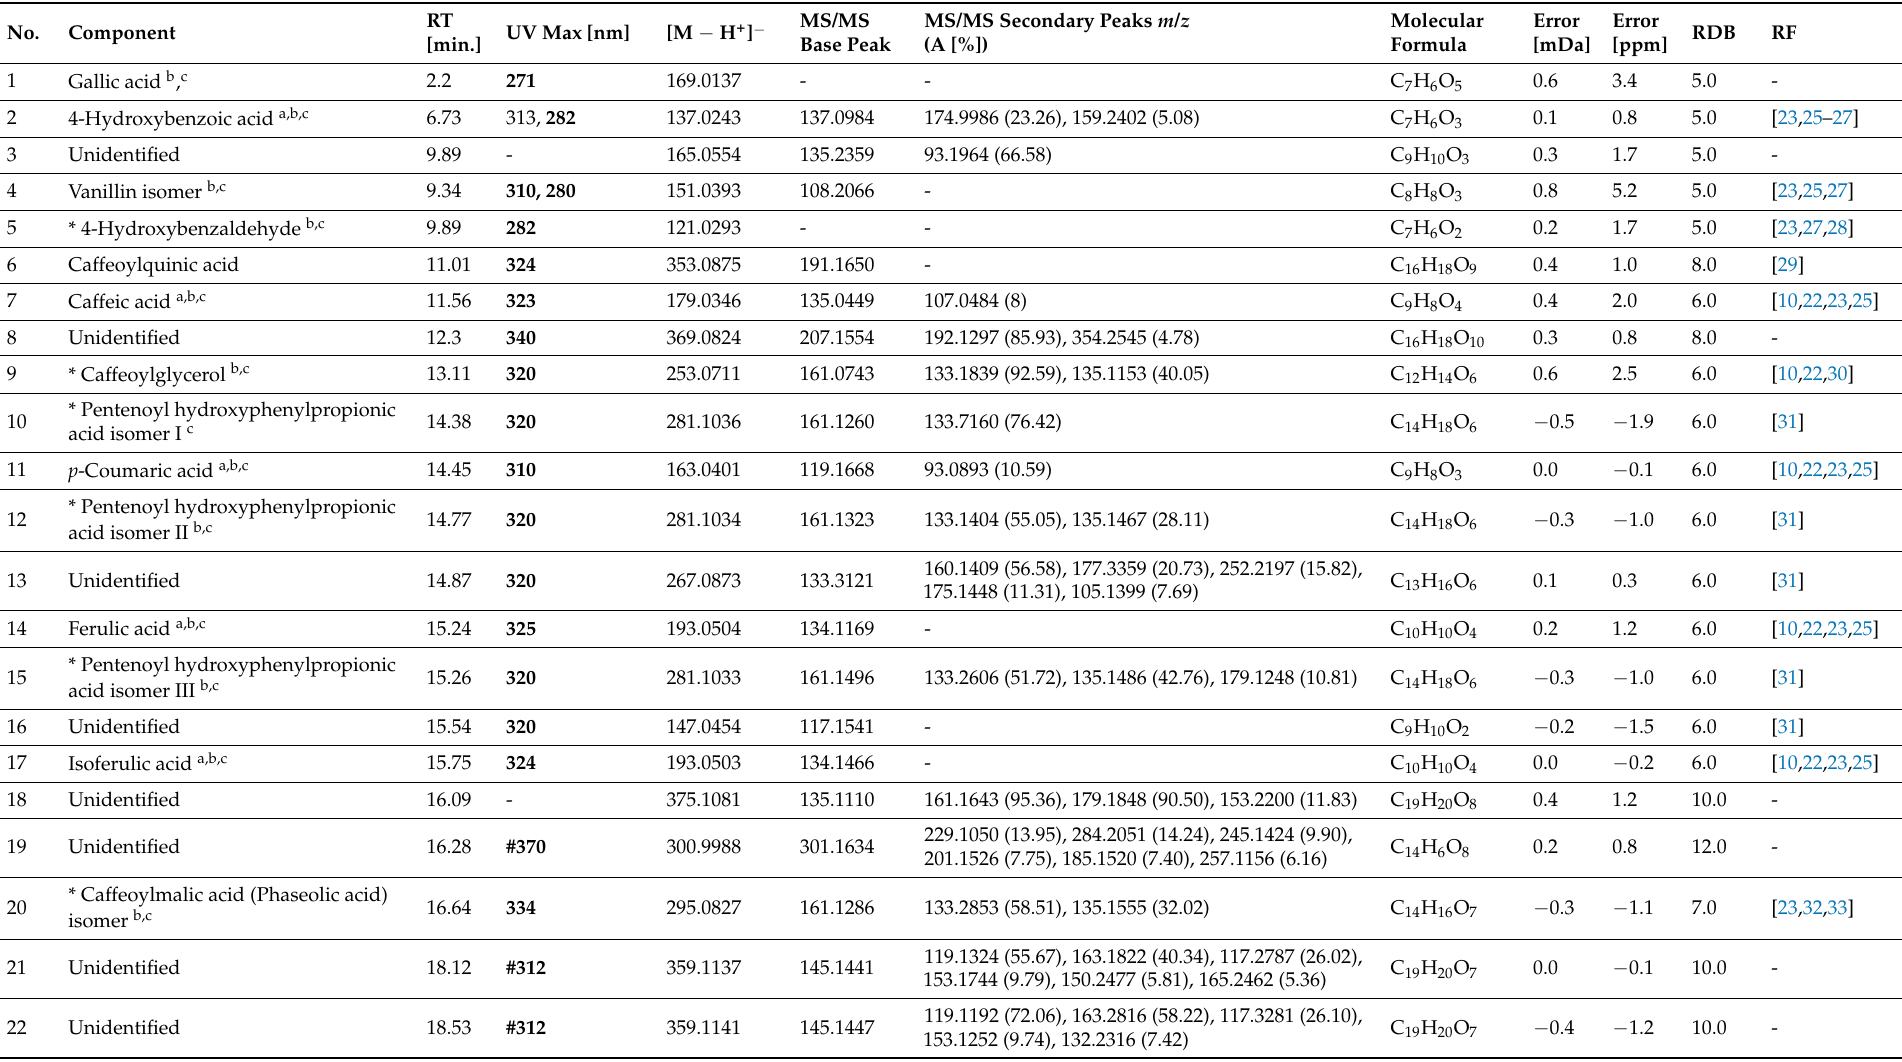
Table 1. Chemical composition of 70% ethanolic extracts of Georgian